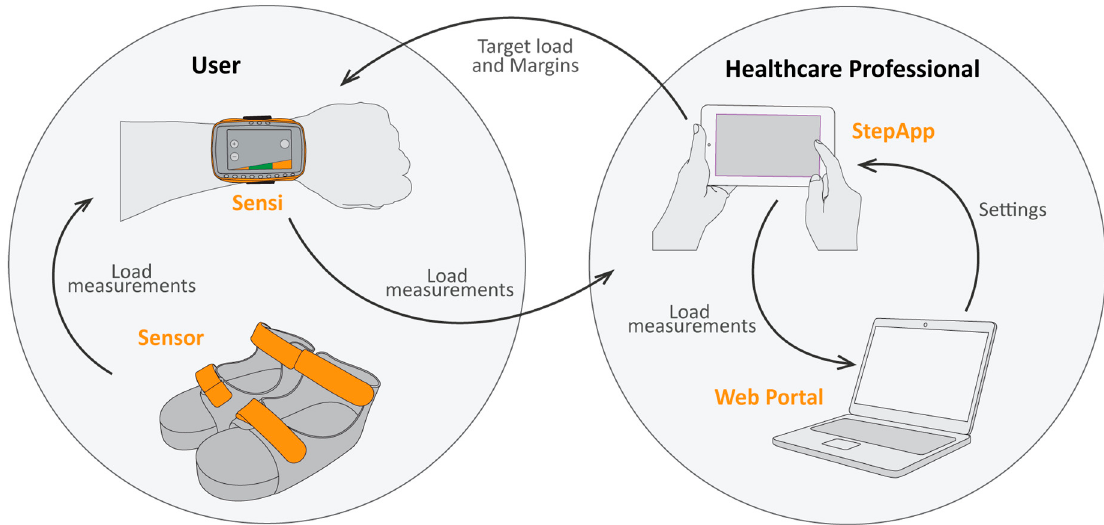
Figure 1. Schematic representation of the biofeedback system with the five components: the insole sensor sends load measurements wireless and in real-time to a wrist device (Sensi), which acts as feedback instrument for the patient. These load measurements are then sent wireless and in real-time to a tablet, which acts as feedback instrument for the healthcare professional. The healthcare professional sets the desired target load and margins in the tablet (StepApp). Finally, all sessions are saved on a secured Web Portal.